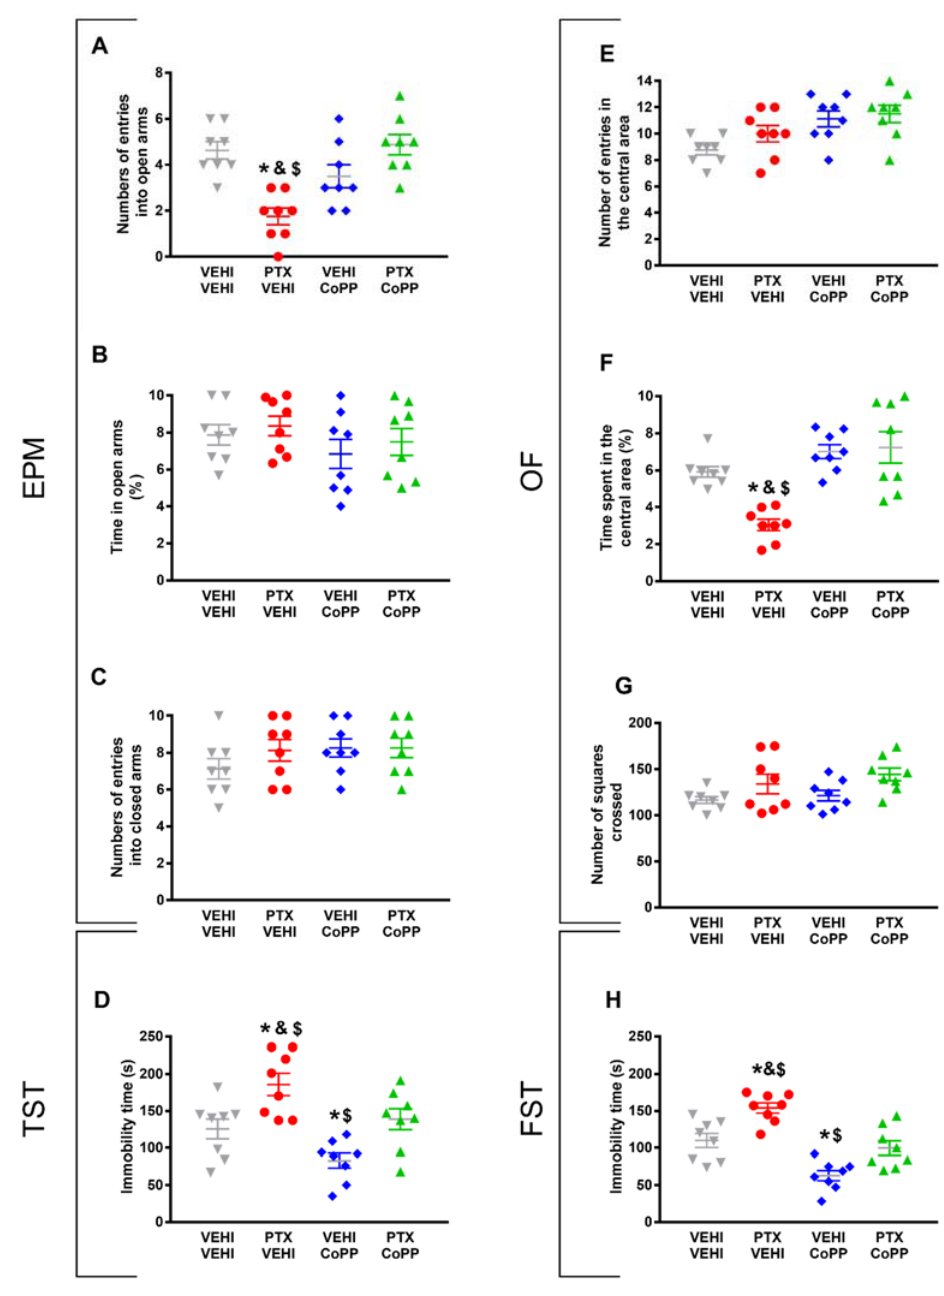
Figure 3. Effects of treatment with CoPP on the emotional behavioral disorders associated with PTX-induced neuropathic pain. Effects of the repetitive administration of 5 mg/kg of CoPP or vehicle from days 17 to 21 after PTX or vehicle (VEHI) injection on the anxiety- (EPM and OF tests) and depressive-like behaviors (TST and FST) associated with CIPN. In the EPM test, the number of times that animals entered the open arms ( A ), the percentage of total time spent in open arms ( B ), and the number of entrances into the closed arms ( C ) are represented. In the OF test, the number of entries into the central area ( E ), the percentage of time spent within the central area ( F ), and the total number of squares crossed ( G ) are shown. Figures ( D , H ) display the time the animals spent in immobility (s) in the TST ( D ) and FST ( H ). In all panels, * indicates significant differences vs. the vehicle–vehicle-treated animals; &, vs. the vehicle–CoPP-treated animals; and $, vs. the animals treated with PTX plus CoPP ( p < 0.05, one-way ANOVA followed by the SNK test). Data are expressed as mean values ± SEM; n = 8 animals per experimental